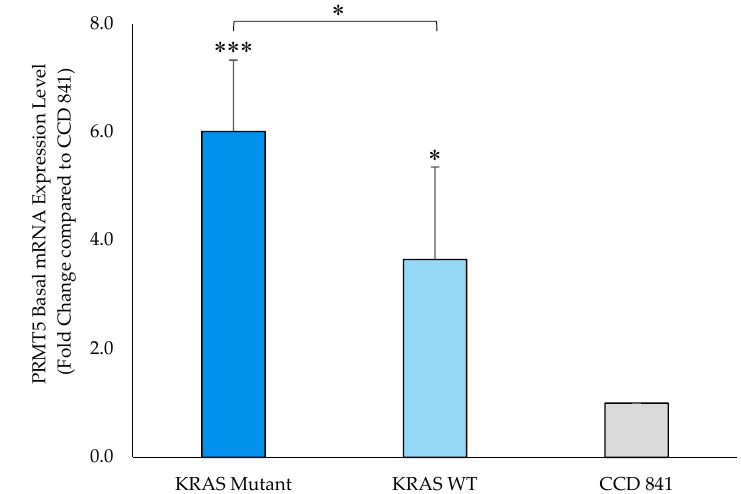
0.02.04.06.08.0